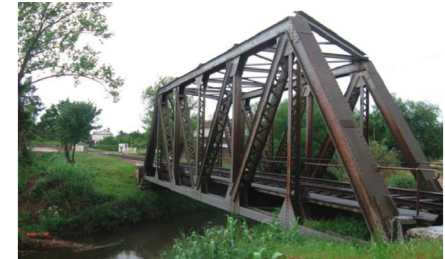
Figure 3: ´Obidos bridge view.